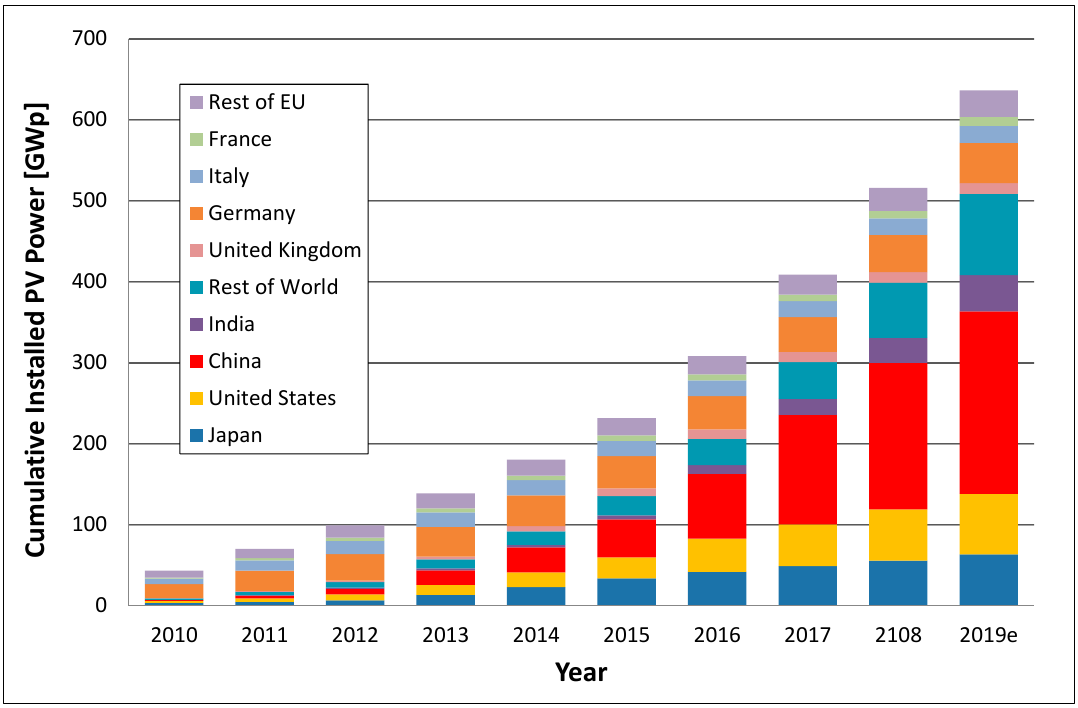
Figure 3. Cumulative photovoltaic installations from 2010 to 2019 (data source: [12–14], and own analysis).